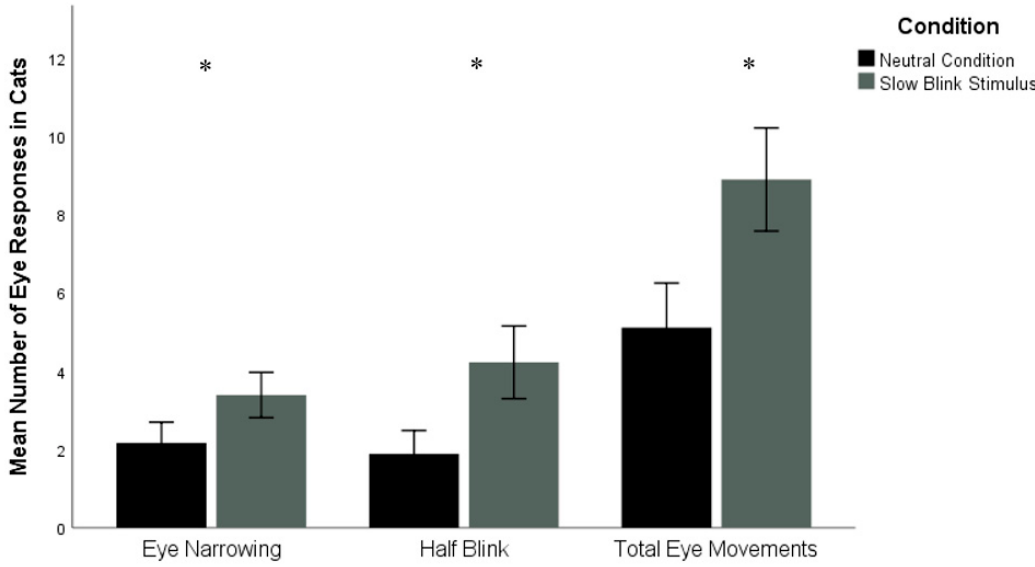
Figure 3. Mean number of instances of cat eye narrowing, half blinks, and total eye movements in the control versus slow blinking trials ( n = 18). Error bars represent ± 1 standard error. * p < 0.05. Tests also indicated that the duration of cat half blinks was significantly longer in the slow blinking trials (M = 2.69 ± 2.83) compared to the control trials (M = 1.06 ± 1.37, Z = − 2.27, p = 0.02, d = 0.73). The duration of cat eye narrowing approached significance between the slow blinking